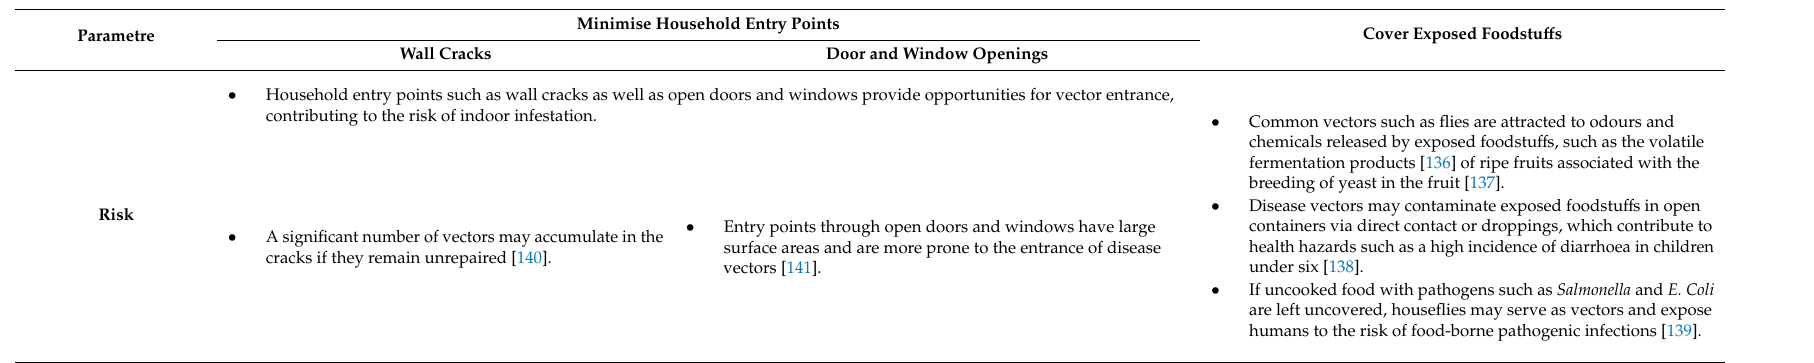
Table 4. Customary Household Practices as Health-EDRM Primary Prevention Approaches against